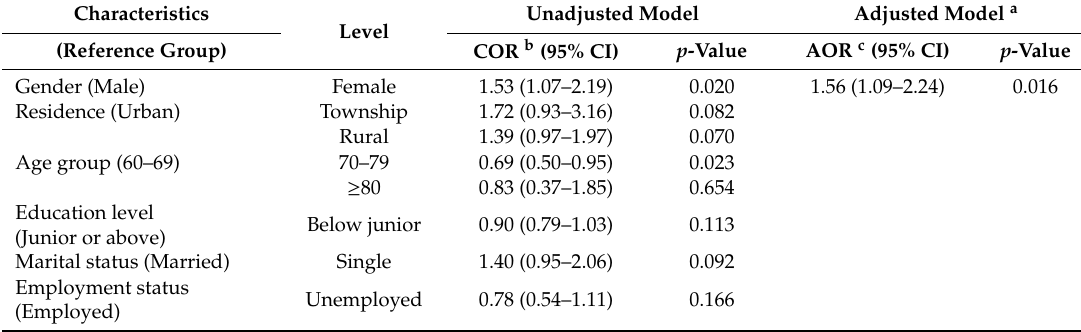
Table 3. Factors influencing medication non-adherence among older adults with